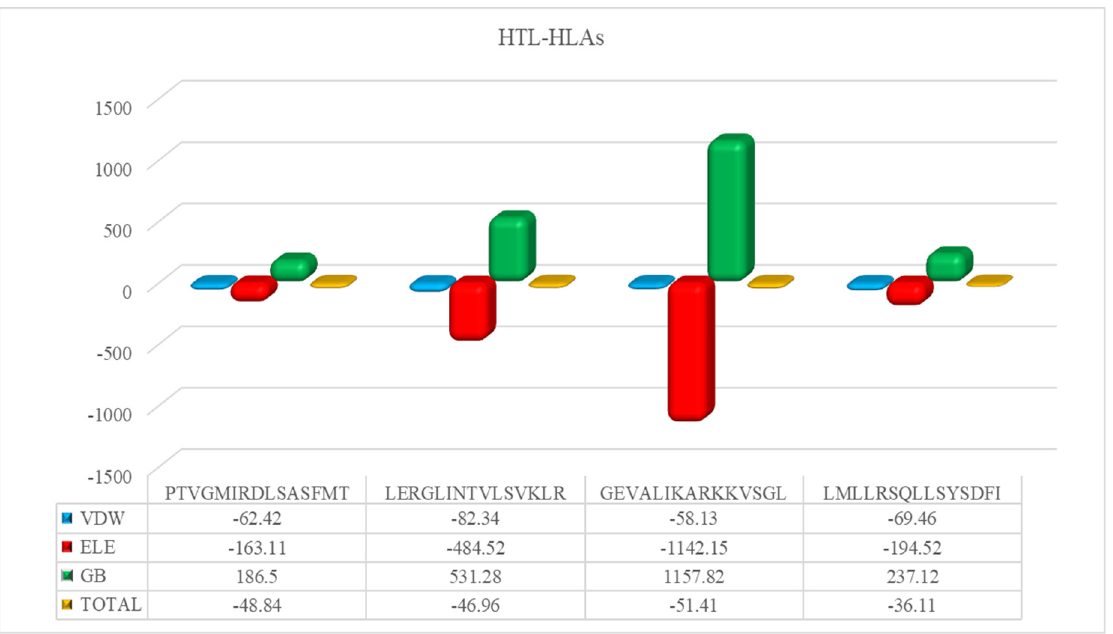
Figure 5. The vDW energy, Electrostatic, and Binding free energy for selected CTL epitopes in complex with respective HLA molecules.